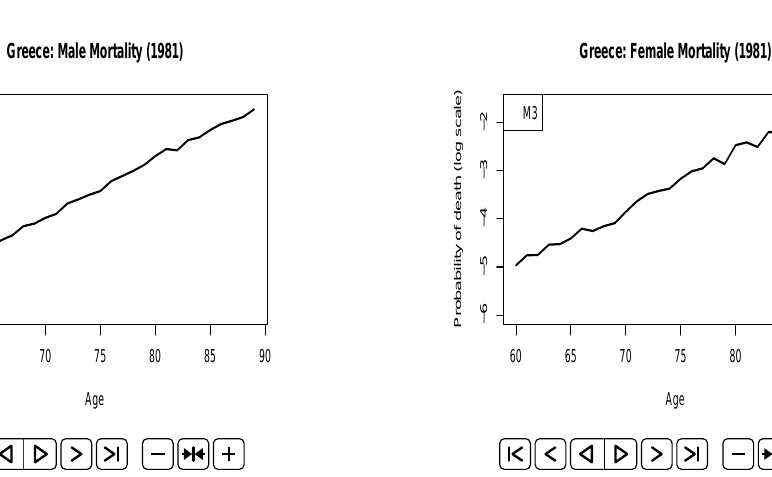
Figure A3. M 3 for males and